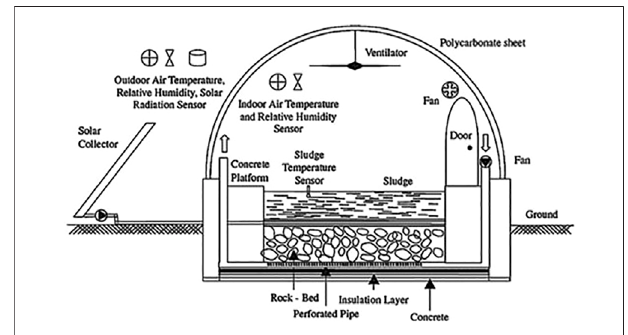
FIGURE 5 | Structure of a covered solar dryer (Kamil Salihoglu et al.,